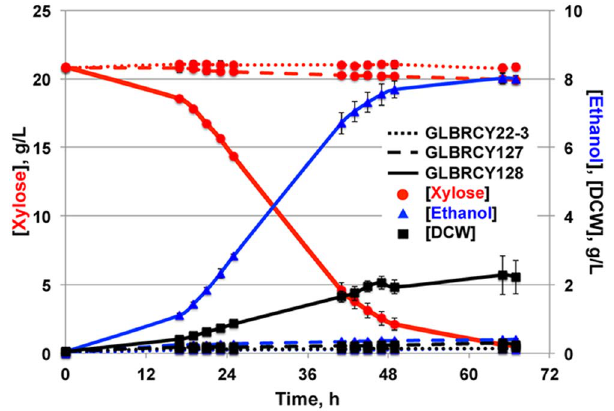
Figure 4. GLBRCY128 can anaerobically ferment xylose from YPX medium into ethanol faster than its parental strains. Fermentation kinetic profiles comparing Y22-3, Y127 and Y128 strains cultured anaerobically in bioreactors containing YPX medium and sparged with nitrogen are shown. Average concentrations with standard deviations of xylose, ethanol and DCW concentrations in the media were calculated from independent biological triplicates.